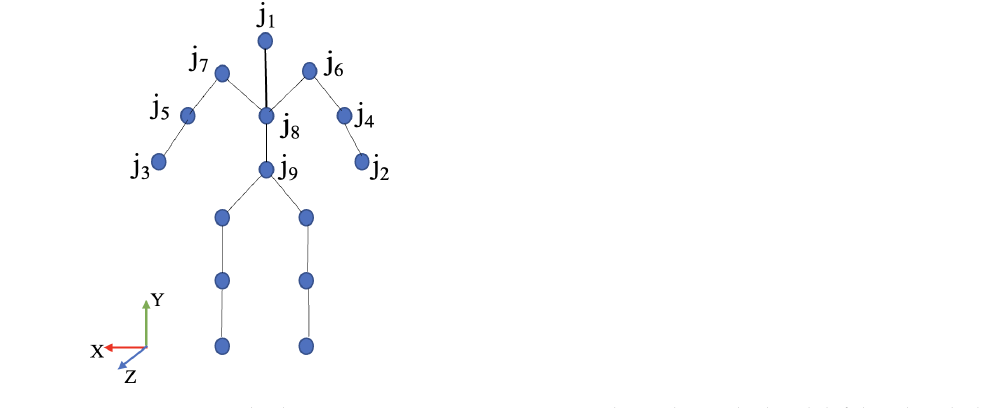
Figure 2. Upper body joints j 1 , j 2 , j 3 , j 4 , j 5 , j 6 , j 7 , j 8 , and j 9 indicate the head, left hand, right hand, left elbow, right elbow, left shoulder, right shoulder, spine, and pelvis.